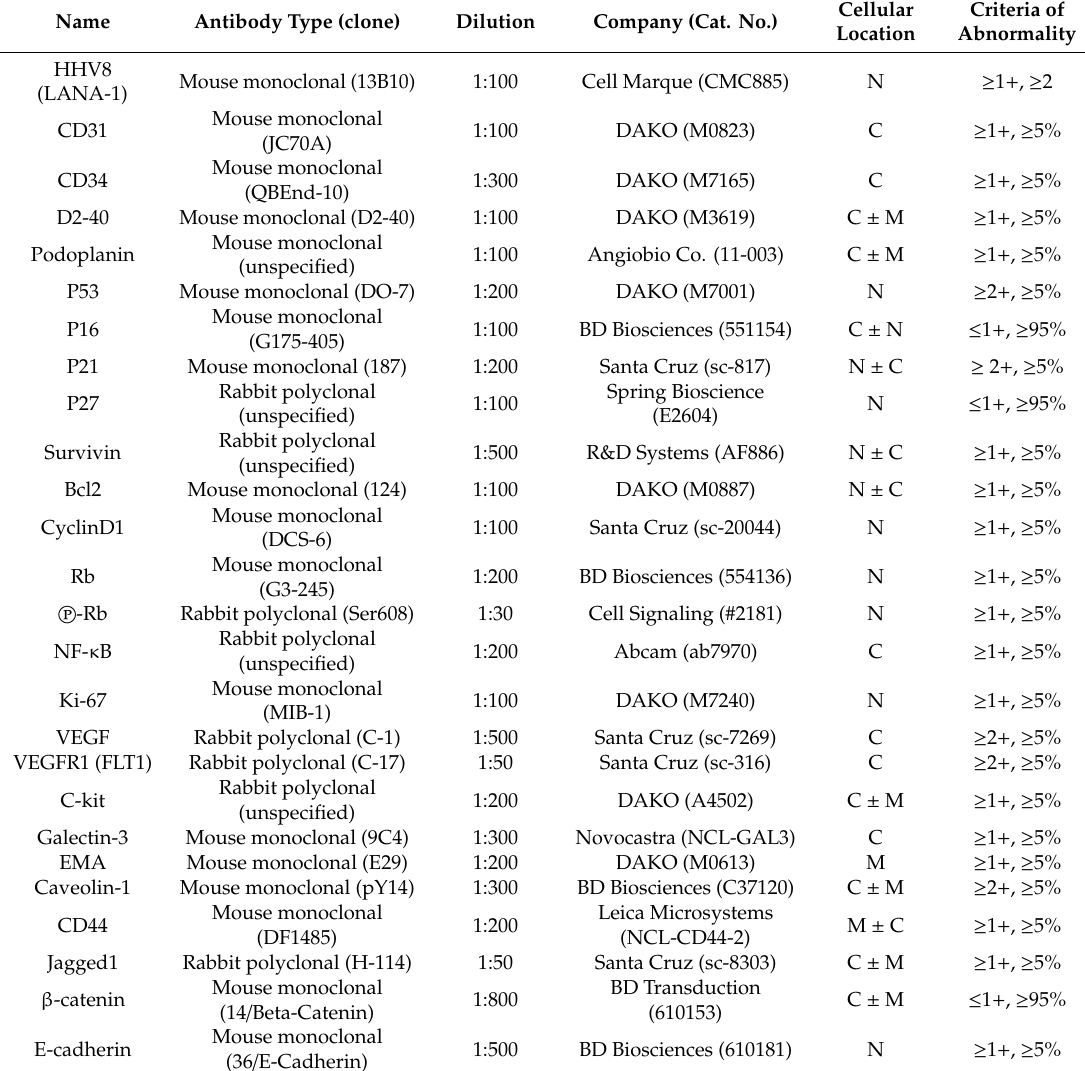
Table 5. Information of 25 primary antibodies and interpretation